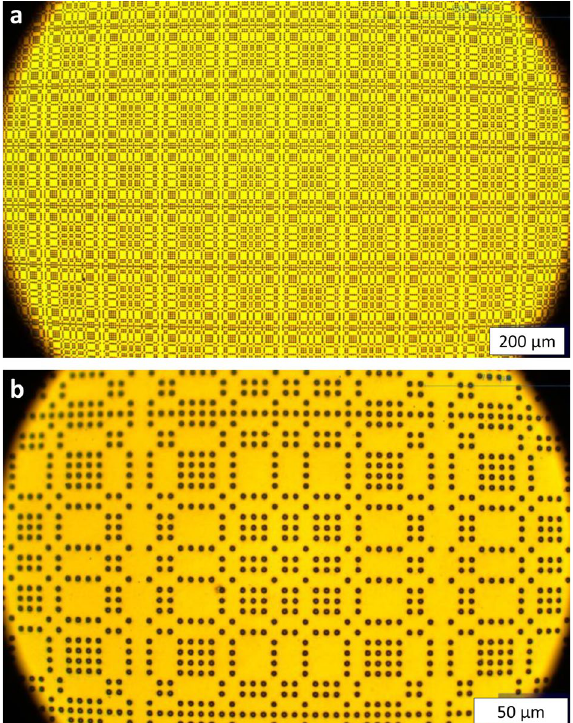
Figure4. Exemplary optical microscope pictures of a MURA. ( a ) overview, ( b ) detailed.